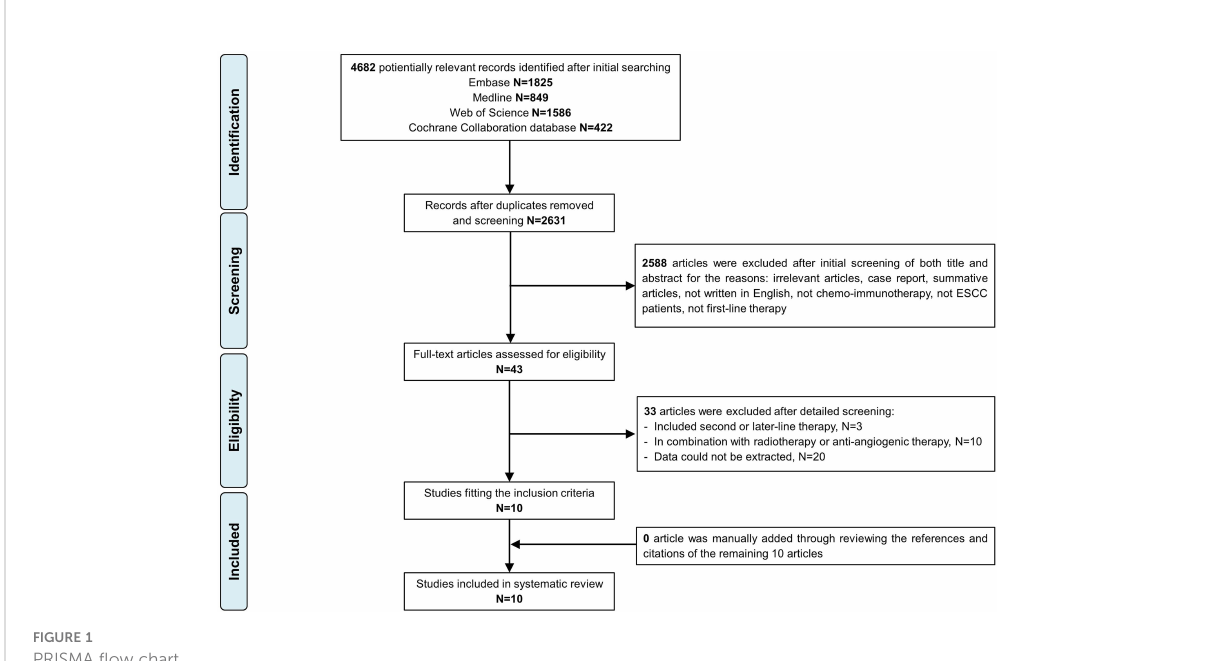
FIGURE 1 PRISMA fl ow